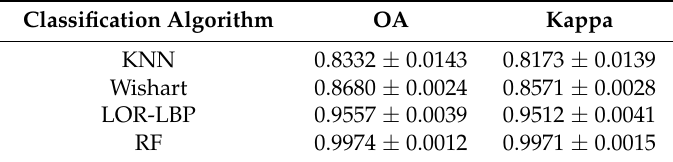
Table 3. Classification results obtained for the AIRSAR imagery with the different classification algorithms.